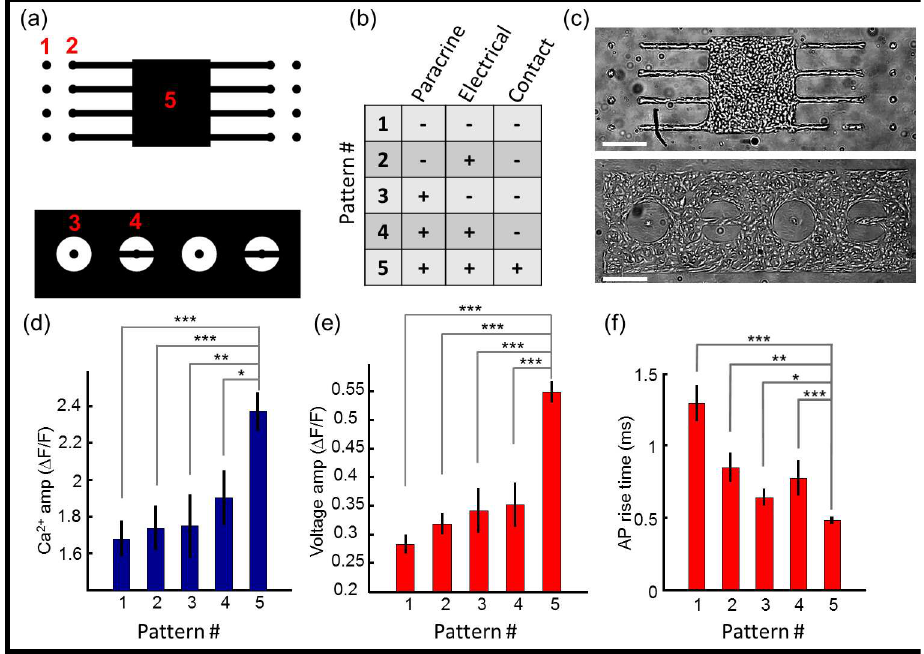
Fig 5. Growth on patterned islands identifies factors that influence hiPSC-CM maturation. a) Cells were cultured on patterned islands with five regions in which different intercellular influences were active. b) Chart showing the modes of intercellular interaction active in each region. c) Image of hiPSC-CM cultured on patterned islands. Scale bar 500 μ m. d) Amplitude of calcium transient; e) Amplitude of voltage transient; f) Action potential rise time, for the five regions indicated in (a). In (d-f) measurements were performed on n = 282 samples. Error bars represent s.e.m. * p (cid:20) 0.05; ** p (cid:20) 0.01; *** p (cid:20)